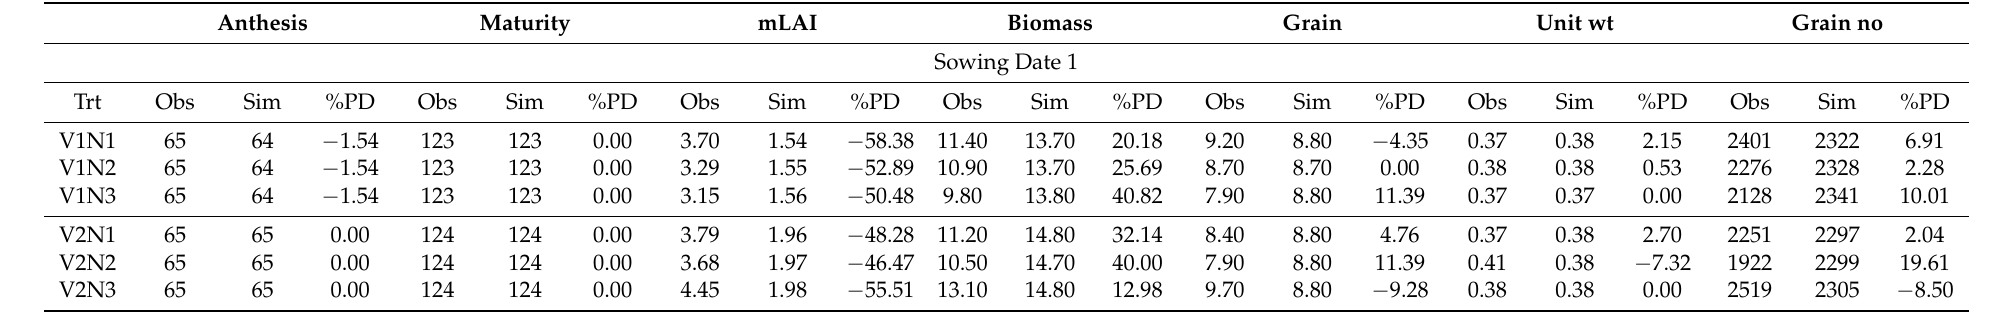
Table A2. Comparison between the observed and simulated phenology, mLAI, biomass, grain and grain size in the CERES-Maize model under the rainfed condition. Reproduced with permission from